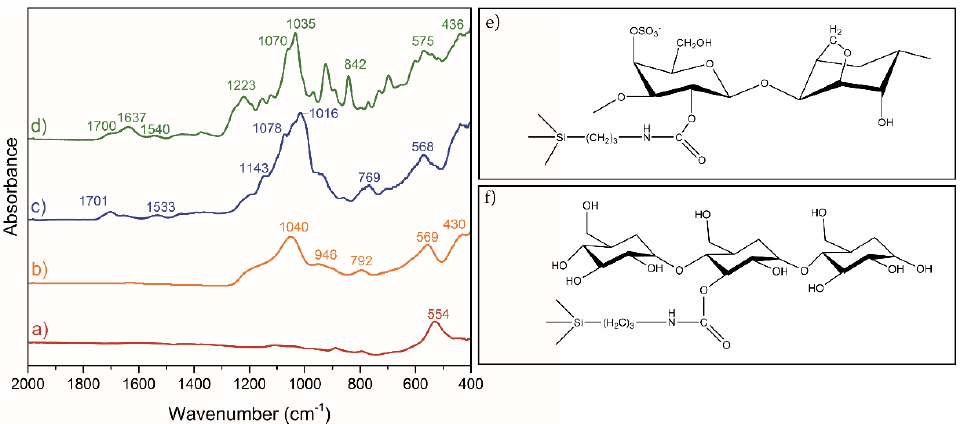
Figure 3. Attenuated total reflectance Fourier transform infrared spectroscopy (ATR-FTIR) spectra (400–2000 cm −1 ) of the samples: ( a ) Fe 3 O 4 ; ( b ) Fe 3 O 4 @SiO 2 ; ( c ) Fe 3 O 4 @SiO 2 / SiStarch; ( d ) Fe 3 O 4 @SiO 2 /SiCRG. Scheme illustrating the formation of urethane bonds in the biopolymer- silica matrix with ( e ) κ-carrageenan and ( f ) amylose from